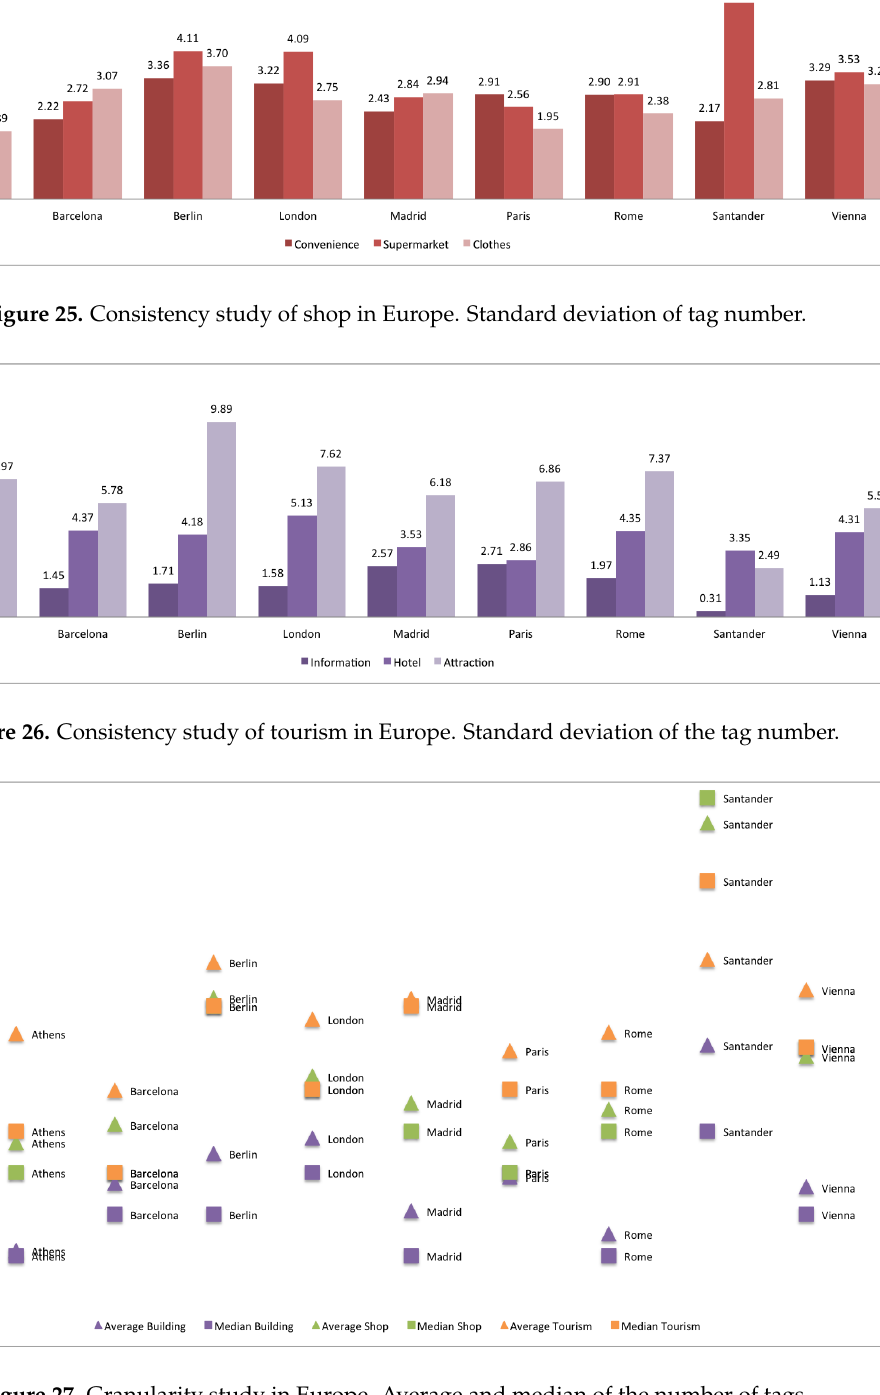
Figure 27. Granularity study in Europe. Average and median of the number of